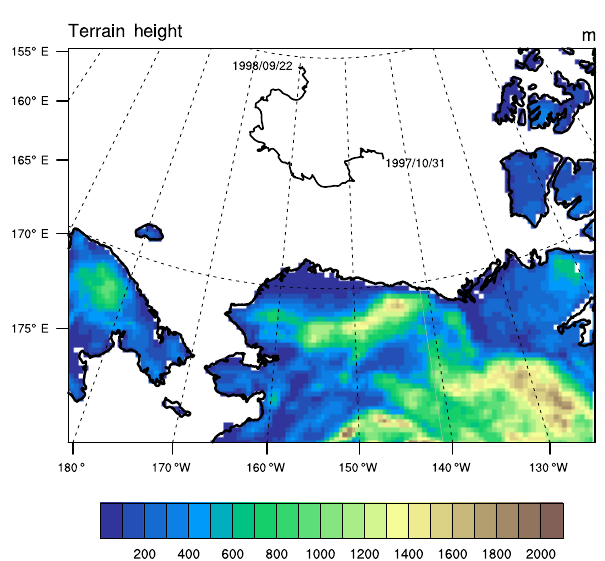
Figure 1. Topography of the simulation domain. SHEBA site loca- tions are marked by the black